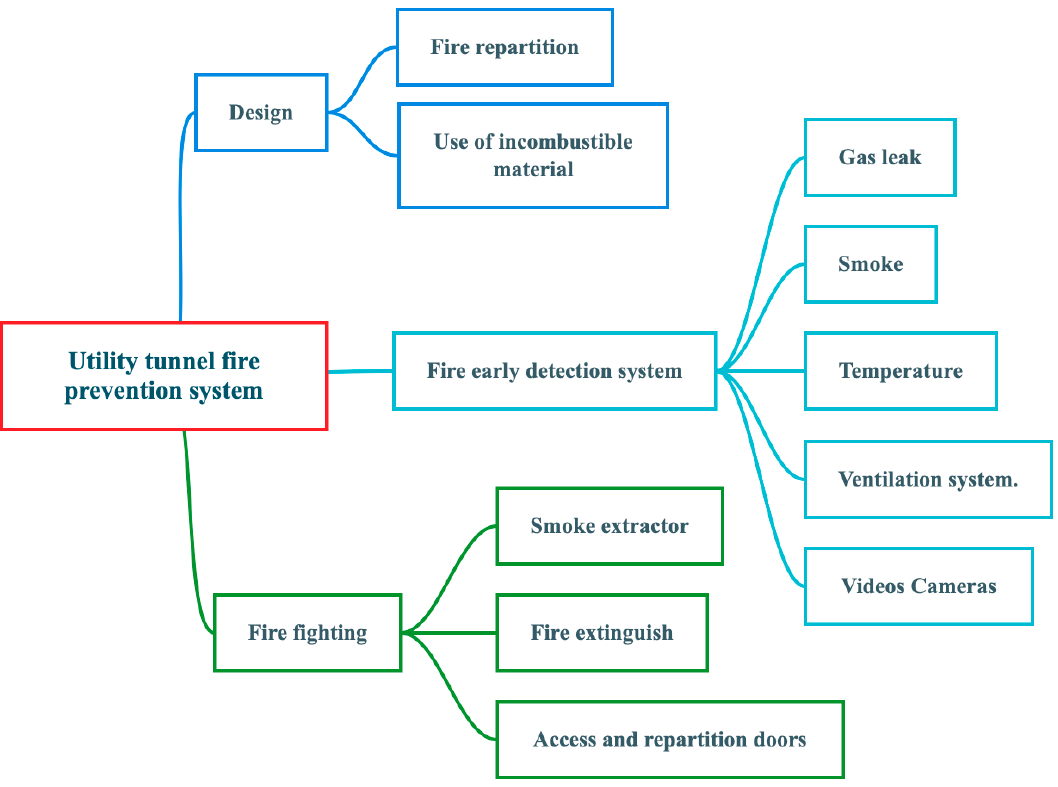
Figure 10. Utility tunnel fire prevention system.